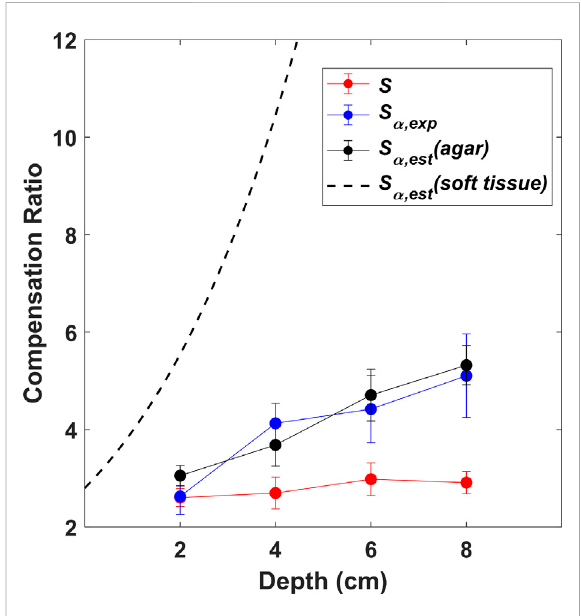
FIGURE 5 Sensitivity compensation ratios as a function of depth obtained experimentally from water medium ( S ) and attenuating agar medium ( S α , exp ), in red and blue. The black solid curve and black dashed curve show values of the estimated sensitivity compensation ratios, using known attenuation coef fi cients of 0.15 dB/cm/MHz ( S α , est (agar)) and 0.7 dB/cm/MHz ( S α , est (soft